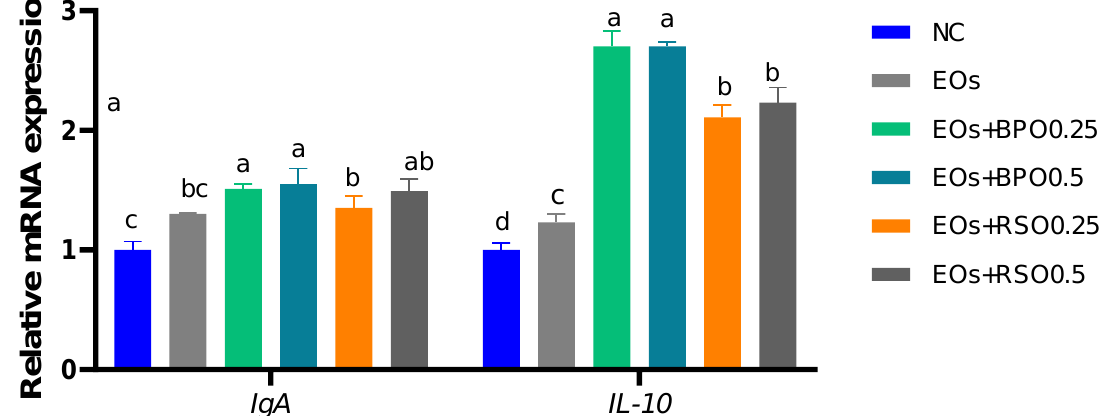
Figure 2. Effect of EOs with black pepper oil or radish seeds oil on mRNA expression of fatty acid synthase (FAS) and acetyl – coA carboxylase (ACC); abcde means within the same column carrying different superscripts are significantly different at ( p < 0.05). EOs mixture of mint, parsley, and carrot oils. NC: feed basal diet without additives; EOs : birds fed a basal diet supplemented with 1.5 g/kg EOs; EOs + BPO0.25: birds fed a basal diet supplemented with 1.5 g/kg EOs plus 0.25 g/kg black pepper oil (BPO); EOs+BPO0.5: birds fed a basal diet supplemented with 1.5 g/kg EOs plus 0.25 g/kg black pepper oil (BPO); EOs + RSO0.25: birds fed a basal diet supplemented with 1.5 g/kg EOs plus 0.25 g/kg radish seed oil (RSO); EOs + RSO0.5: birds fed a basal diet supplemented with 1.5 g/kg EOs plus 0.5 g/kg radish seed oil (RSO).